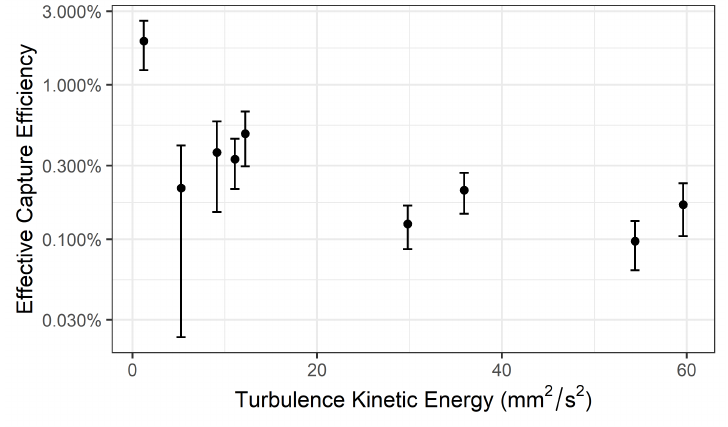
Figure 6. Effective capture efficiency (ECE) as a function of turbulence kinetic energy (TKE) for all experimental treatments studied. Error bars represent ± 1 SE. ECE is plotted on a log scale to make differences at higher TKE values